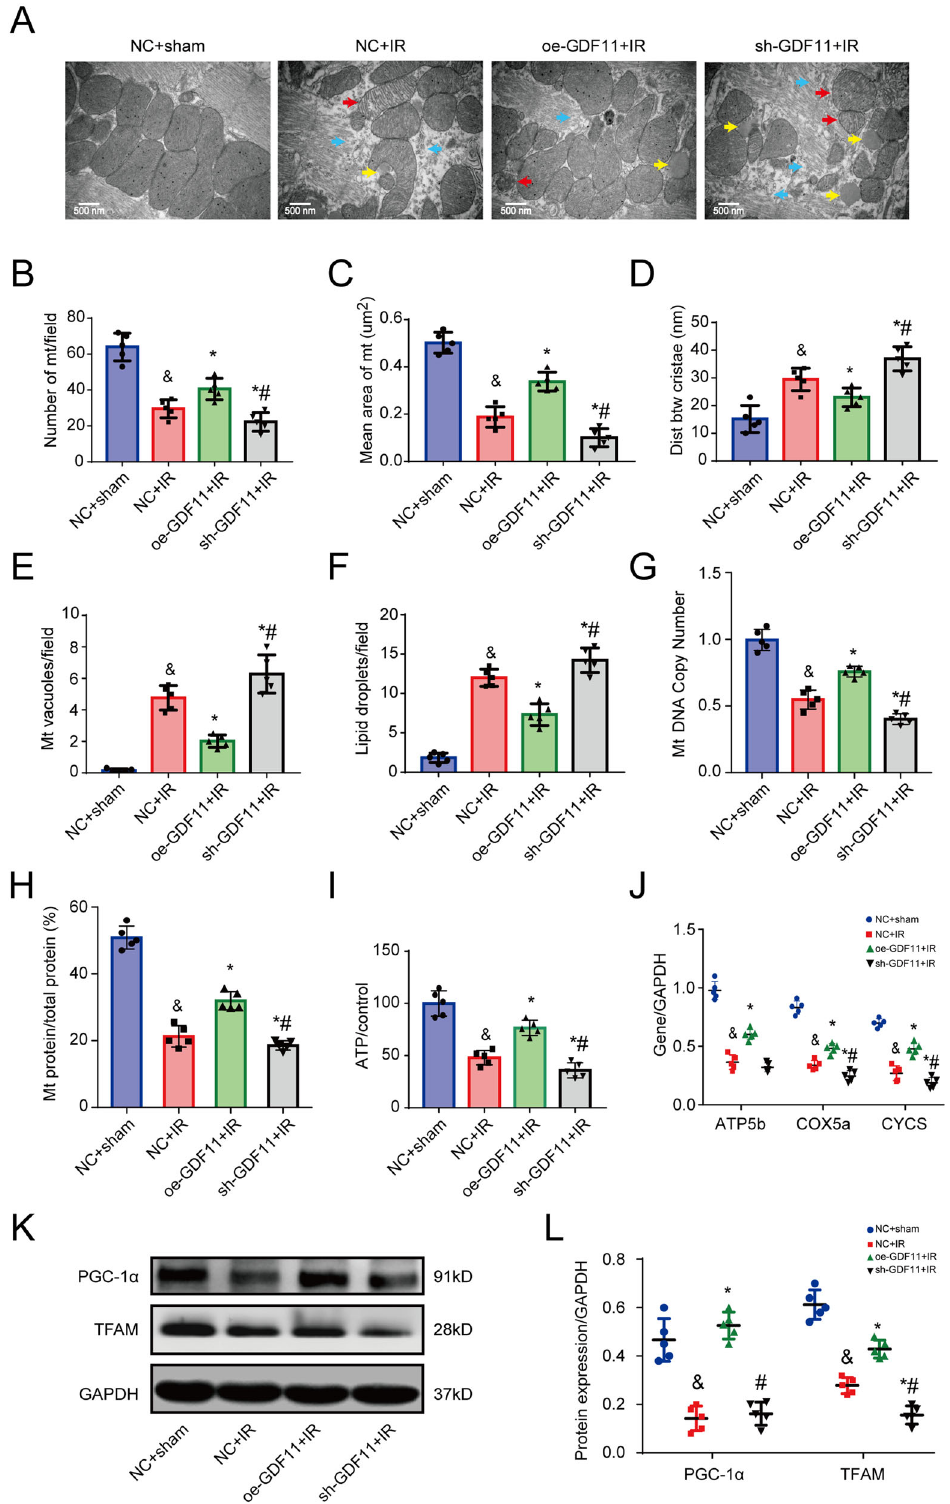
Fig. 4 Effects of overexpressing or silencing GDF11 on mitochondrial damage induced by IR in mice. A Representative pictures of the ultrastructure of myocardial tissue under a transmission electron microscope. Yellow arrows: fat droplets; red arrows: vacuolated mitochondria (mt); blue arrows: broken myocardial fi bril. B The number of mitochondria per fi eld. C The mean area of a mitochondrion. D The distance between (btw) mitochondrial cristae. E The number of vacuoles per fi eld. F The number of lipid droplets per fi eld. G The mitochondrial DNA (mtDNA) copy number. H The proportion of mitochondrial protein relative to total myocardial protein. I ATP production. J mRNA expression of ATP5b, CYCS, and COX5a. K Representative images of western blots for PGC-1 α and TFAM. L Semiquantitative analysis of the protein expression of PGC-1 α and TFAM. & p < 0.05 vs. the sham group; * p < 0.05 vs. the IR group; # p < 0.05 vs. the oe-GDF11 + IR group; n = 5, one-way ANOVA followed by Bonferroni ’ s correction for post hoc multiple comparisons in ( B – I ) and ( K ). GDF11 growth differentiation factor 11, IR ischemia/reperfusion, oe-GDF11 GDF11 overexpression, sh-GDF11 short hairpin RNA of GDF11. Cell Death and Disease (2021)